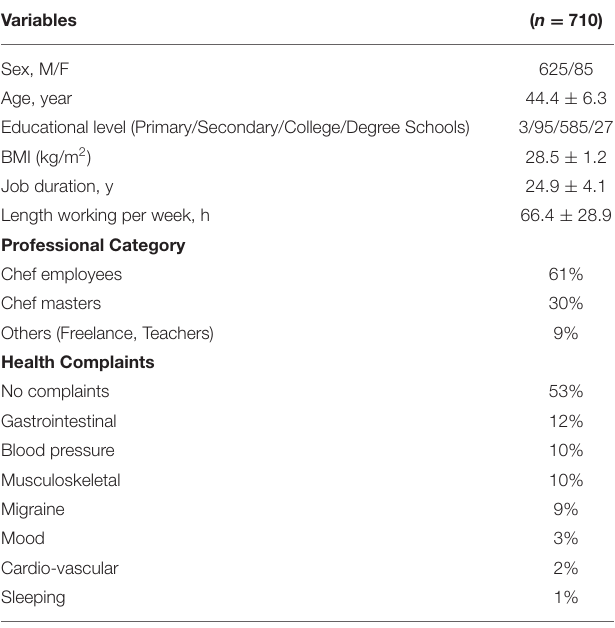
TABLE 1 | Individual features of